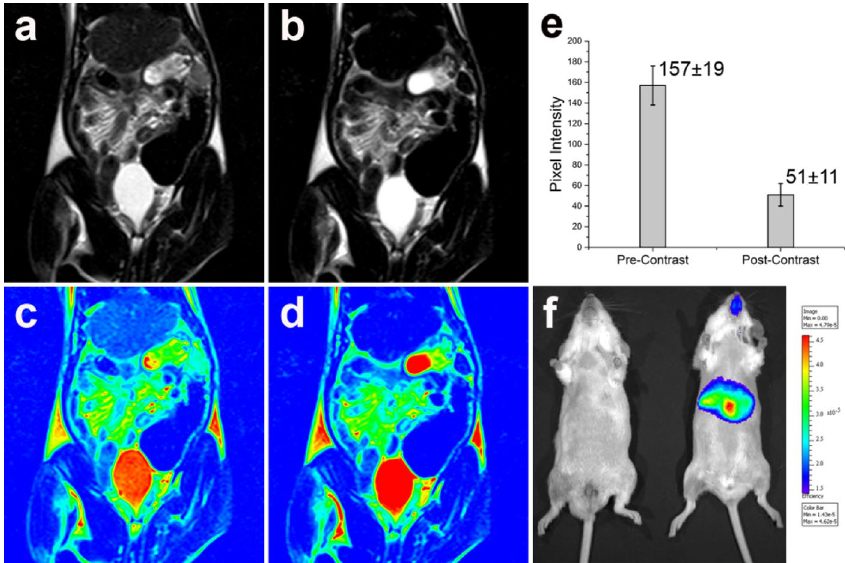
Figure 4. In vivo evaluation of P-SPIONs. Pre and post contrast in vivo MR images ( a ) and ( b ). The pseudo coloured images generated from ( a ) and ( b ) for easy identification are shown in ( c ) and ( d ). ( e ) The percentage signal intensity variation from pre to post contrast MR image of liver fibrosis rat model administered with P-SPIONs. ( f ) In vivo optical images of control and fibrosis induced mice model administered with PSPION-AT. Images were acquired after 15 min of intravenous administration of PSPION-AT through tail